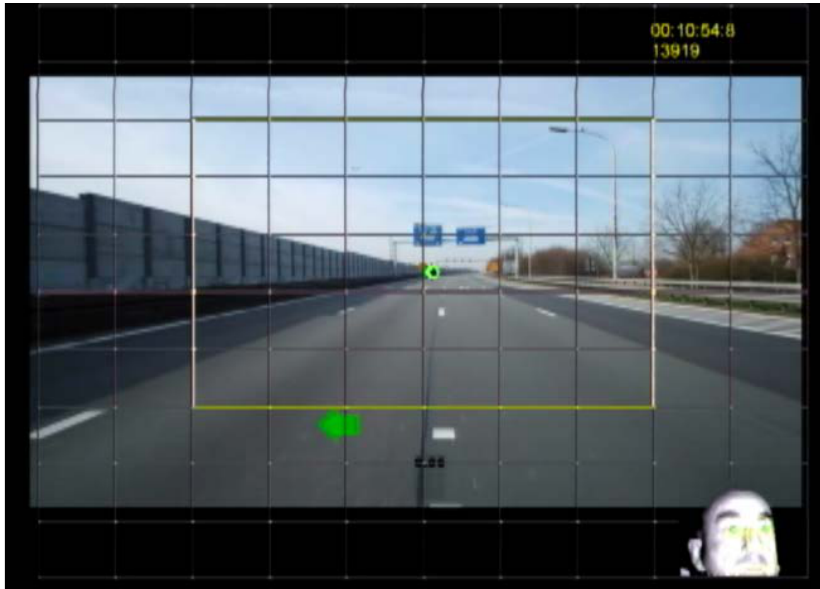
Figure 6. Example of overlay